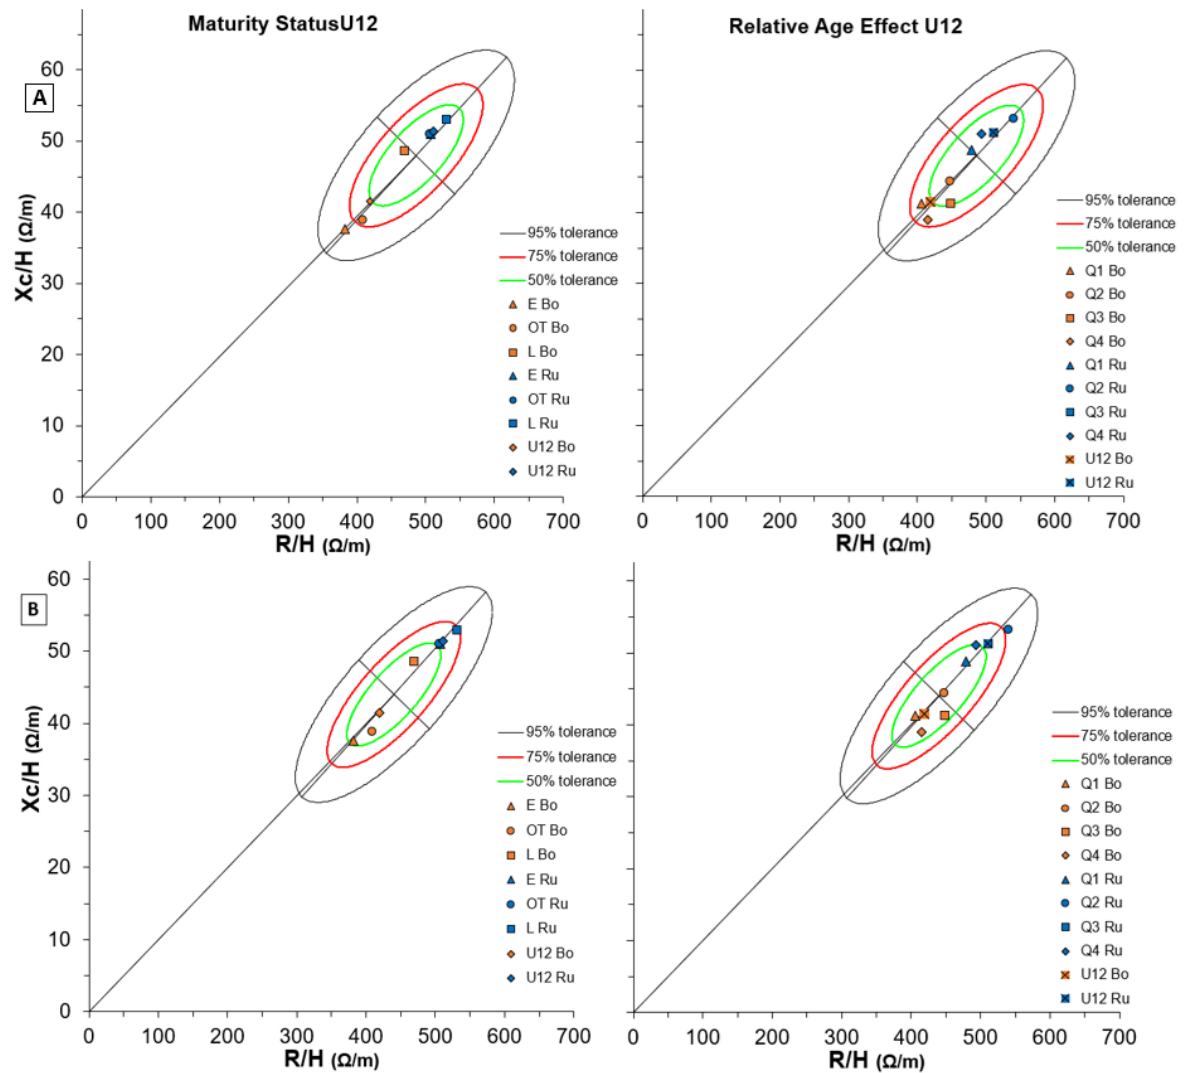
Figure 6. BIVA tolerance with Maturity Status (left) and Relative Age Effect (right) of both Bologna and Russi U12 groups for two reference populations: ( A ) number 112 (males, white, age 10–11 years, BMI 18, Italy, Akern-RJL Systems); ( B ) number 114 (males, white, age 12 years, BMI 18, Italy, Akern-RJL Systems). Note: U15 Bo and U15 Ru refer to team means respectively.